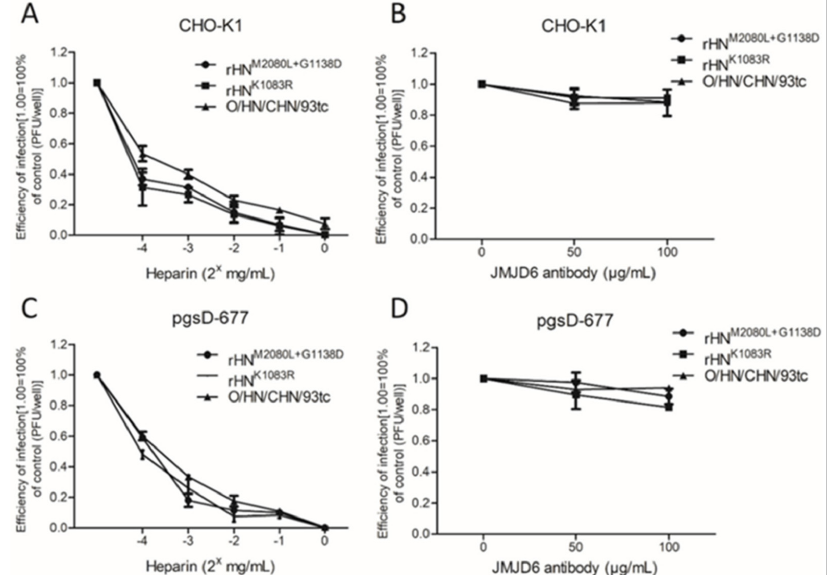
Figure 4. Effects of heparin and JMJD6 antibody on the infectivity of the specific FMDVs in two integrin-negative CHO cell lines. The plaque reduction assays were performed after the neutralization of FMDV with heparin (2 x mg/mL, x = − 4~0) or by pre-treatment with blocking antibodies to JMJD6 (0, 50, 100 μ g/mL) on ( A , B ) CHO-K1 and ( C , D ) pgsD-677 cells.